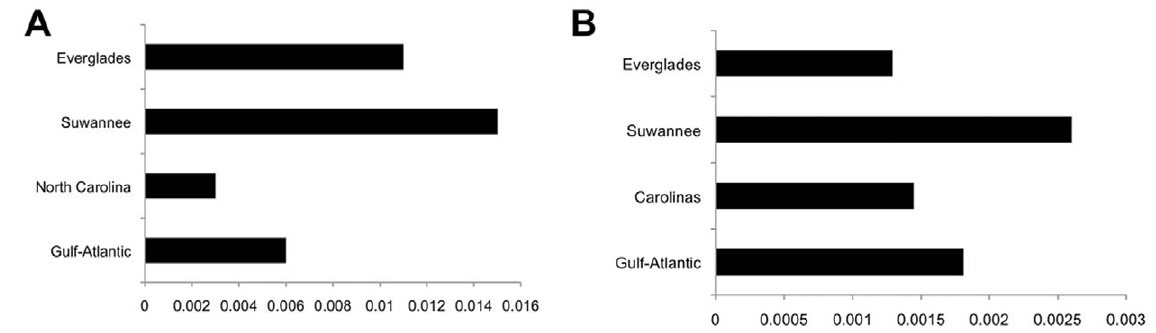
Figure 5. Pairwise distances within populations. A: Tamura-Nei corrected distance within each mitochondrial clade. B: Average p-distance across nine nuclear loci within each STRUCTURAMA-inferred population.